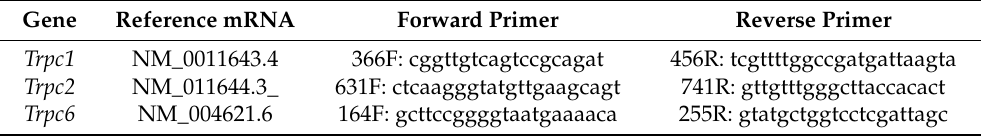
Table 1. Primers used in the qRT-PCR